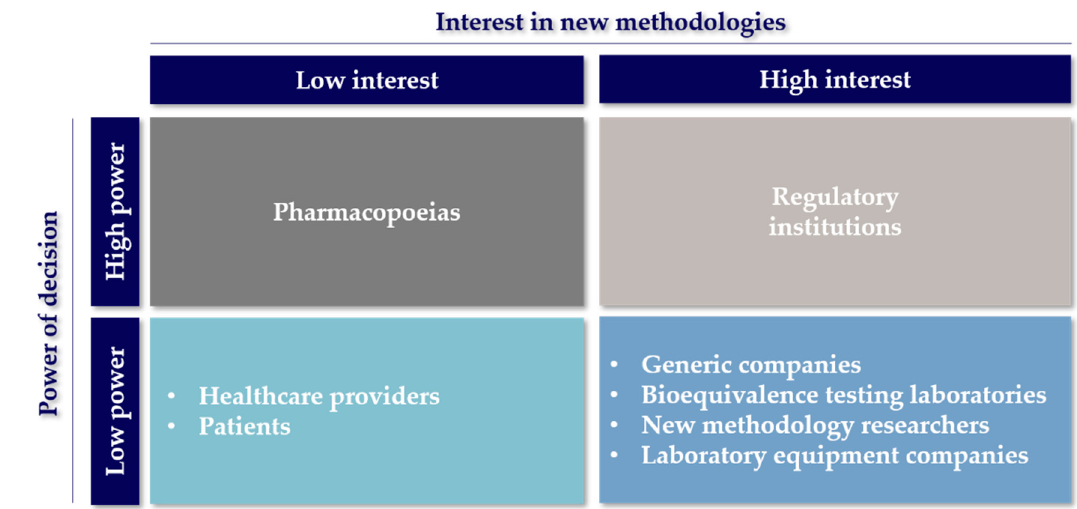
Figure 2. Stakeholders involved in the research of alternative methods for bioequivalence of OIDPs. Stakeholders are classified according to their interest in the development of new techniques vs. the decision making capacity and their authority to execute the decisions related to their effective use.